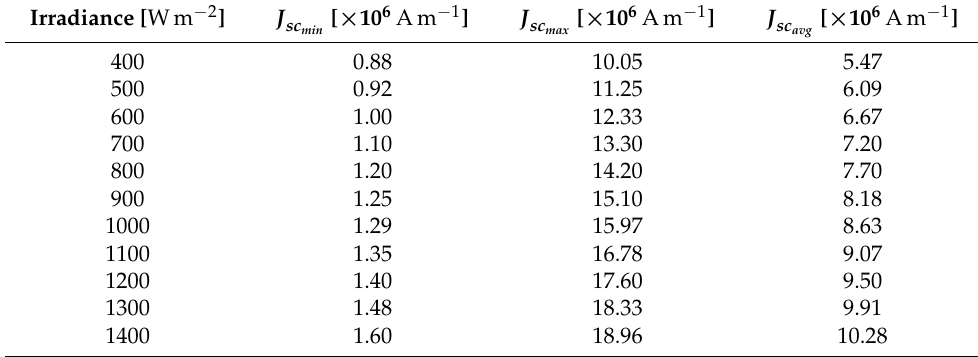
Table 5. Values of the current density norm with the input irradiance.